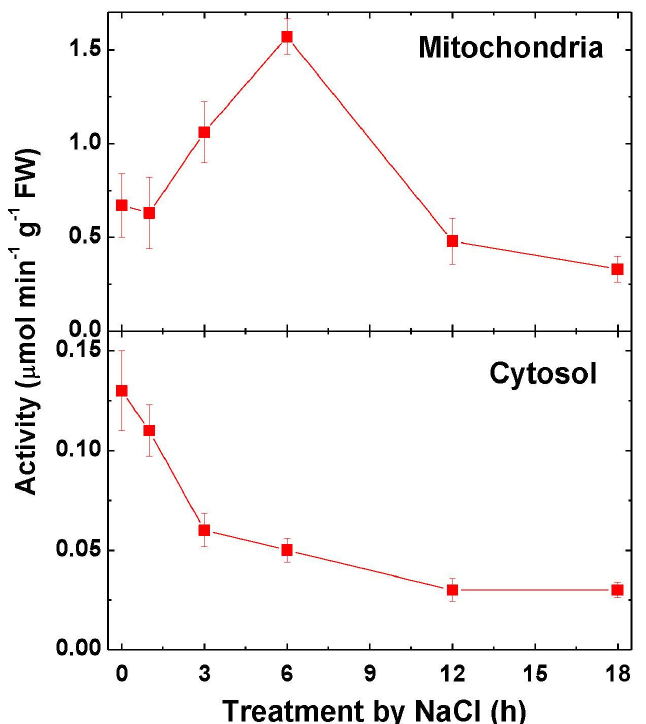
Figure 4. Change in the activity of fumarase in the mitochondrial and cytosolic fractions after the transfer of maize seedlings in 150-mM NaCl. The data represent the means of three biological repeats ± SD. The control (untreated) samples of the values of activity did not exhibit statistically significant changes in the variation level. The expression of fumarase genes Fum1 and Fum2 encoding, correspondingly, the